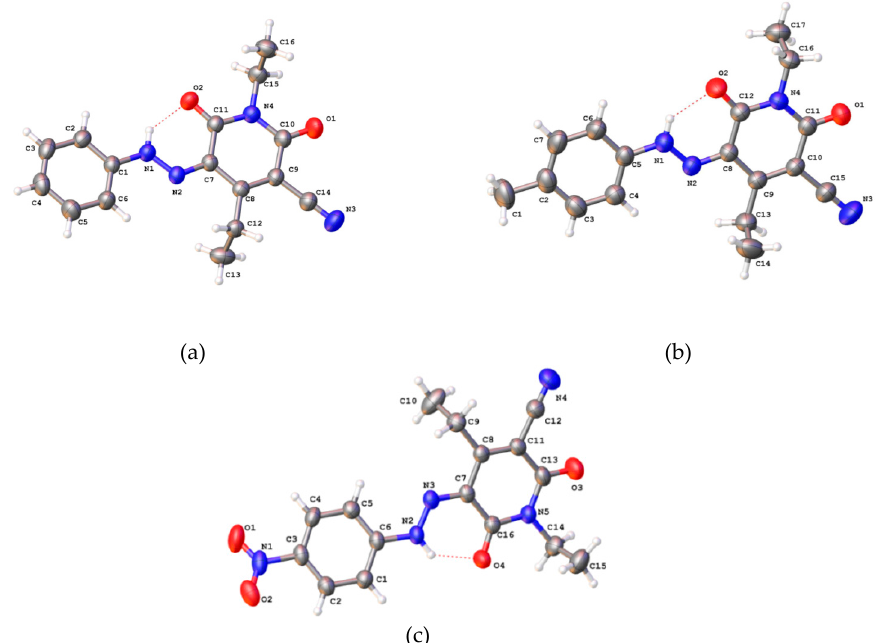
Figure 2. ORTEP structures of (a) dye 14q ; (b) dye 14r and (c) dye 14w.